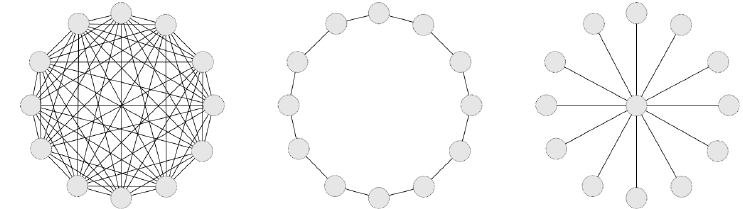
Figure 1. The three PSO topologies used in this work: global, ring, and